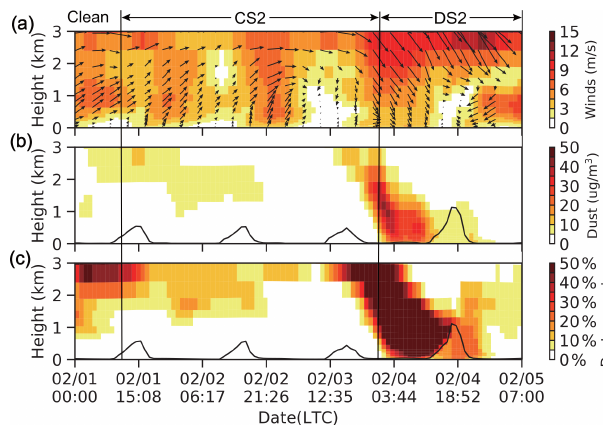
Figure 6. Same as Fig. 5 but from 1 to 5 February 2017.